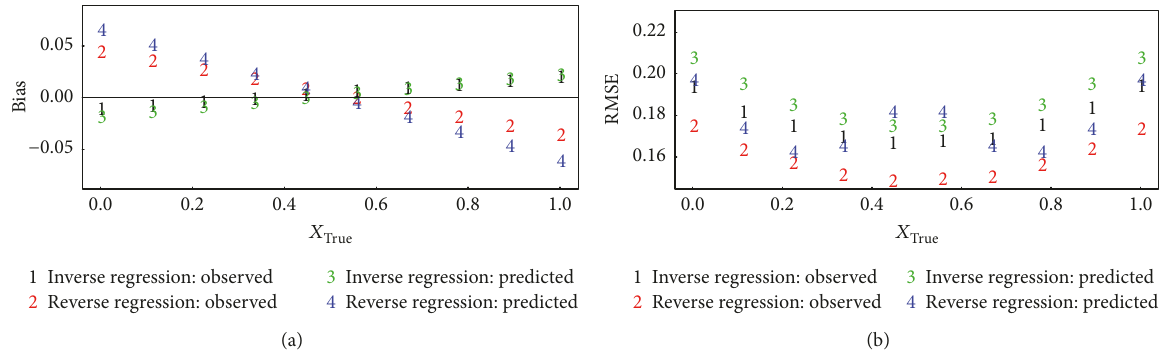
and (b) the observed True